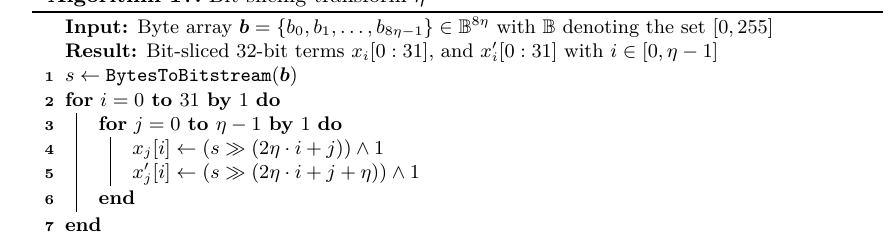
Algorithm 17: Bit-slicing transform